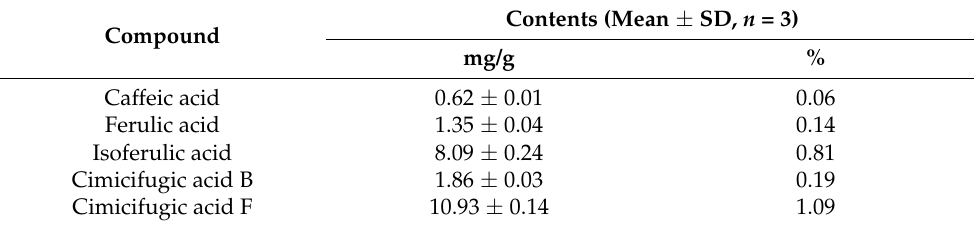
Figure 1. High-performance liquid chromatography (HPLC) chromatograms of five standard com- pound mixtures ( a ) and 70% ethanol extract of Cimicifugae Rhizoma ( b ). Chemical structures of five compounds ( c ). Peak identification: 1 , caffeic acid; 2 , ferulic acid; 3 , isoferulic acid; 4 , cimicifugic acid B; 5 , cimicifugic acid F. Chromatographic conditions are described in the text. Detection was at 320 nm. Table 1. Contents of five compounds in Cimicifugae Rhizoma.